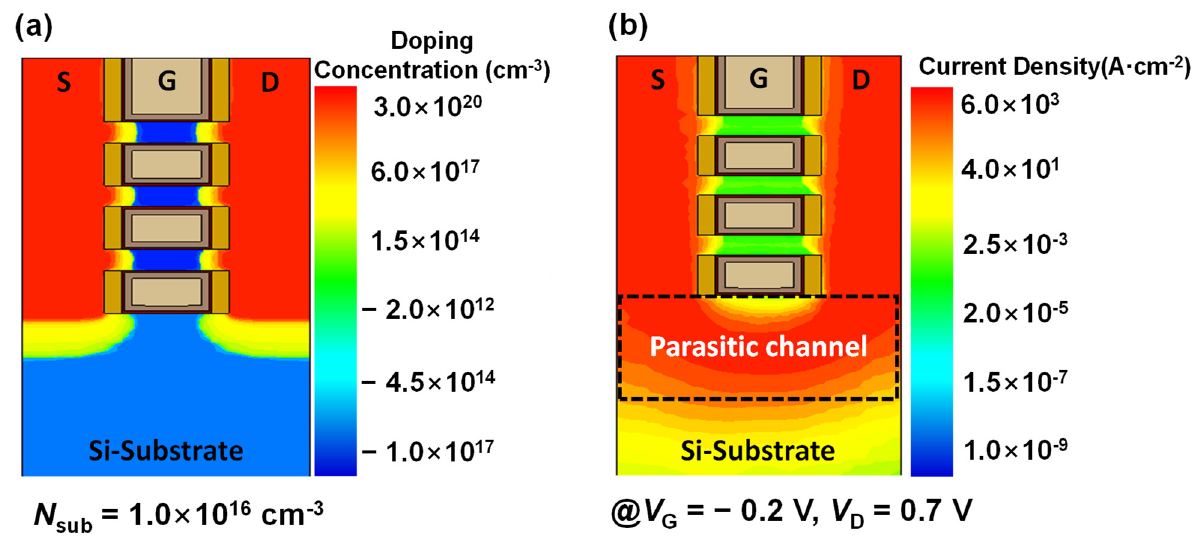
Figure 4. Simulated ( a ) doping profile distribution and ( b ) current density of a NS FET without a DUT layer during off–state.